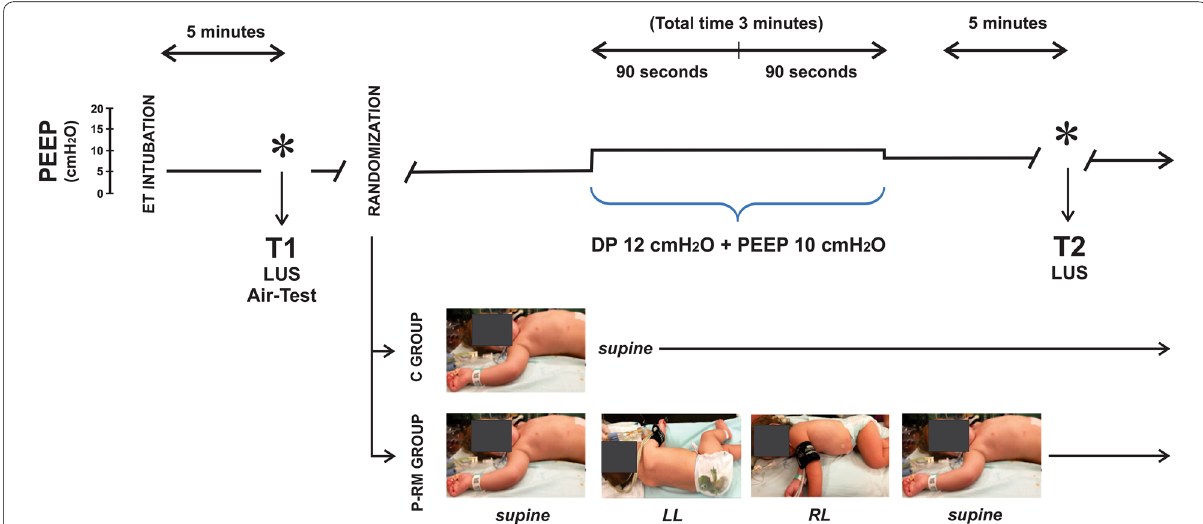
Fig. 1 Diagram of the protocol. Ventilation was switched to pressure control mode using 12 cmH 2 O of driving pressure (DP). PEEP was increased from 5 to 10 cmH 2 O during 3 min. The control group (C group) remained supine along the protocol while children in the postural recruitment group (P-RM group) were turned to the left lateral position (LL) during 90 s and then to the right lateral (RL) for another 90 s, to finally reach the supine position again. T1 analysis 5 min after anesthesia induction, T2 analysis 5 min after treatment, LUS lung ultrasound